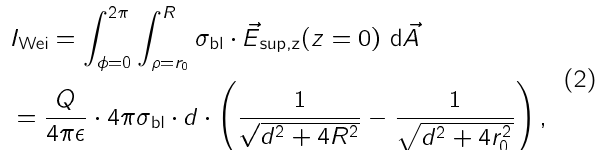
with d A = (cid:26) d (cid:26) d (cid:30) in cylindrical coordinates. R marks